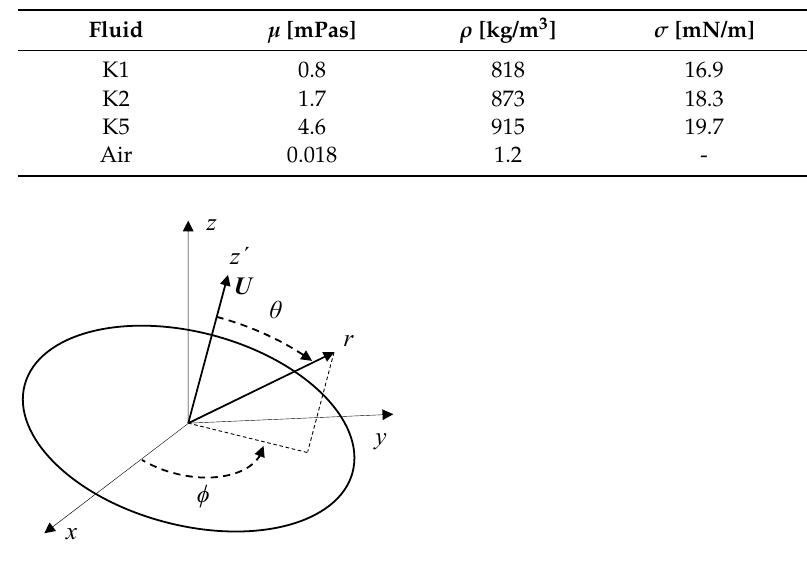
Figure 6. Coordinate system ( r , θ , ϕ ) and ( r , ϕ , z ’) where origin is center of a bubble.